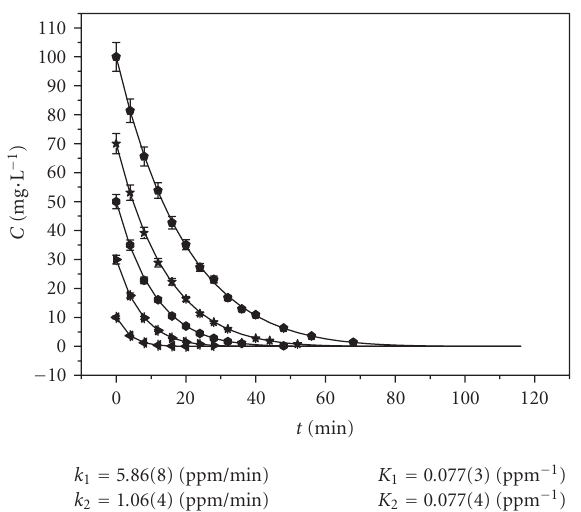
Figure 2: Kinetics of disappearance of total organic carbon (TOC) from 2,4-dichlorophenol (DCP) aqueous solutions. TOC is expressed as concentration, C TOC in mg/L (ppm; mass/volume) of carbon, which was not mineralised, as a function of time t , expressed in min. Absorbed radiation power per unit membrane length was 1.50 W · cm − 1 during these runs. In the laboratory- scale photoreactor (see Experimental) standard photocatalytic membranes, immobilising 30wt.% of P-15 titanium dioxide, were employed. In the Figure the four optimised parameters, k 1 and K 1 , k 2 and K 2 , obtained by kinetic modelling, are also reported for this series of runs, together with the probable error, shown between parentheses, as uncertainty in the last